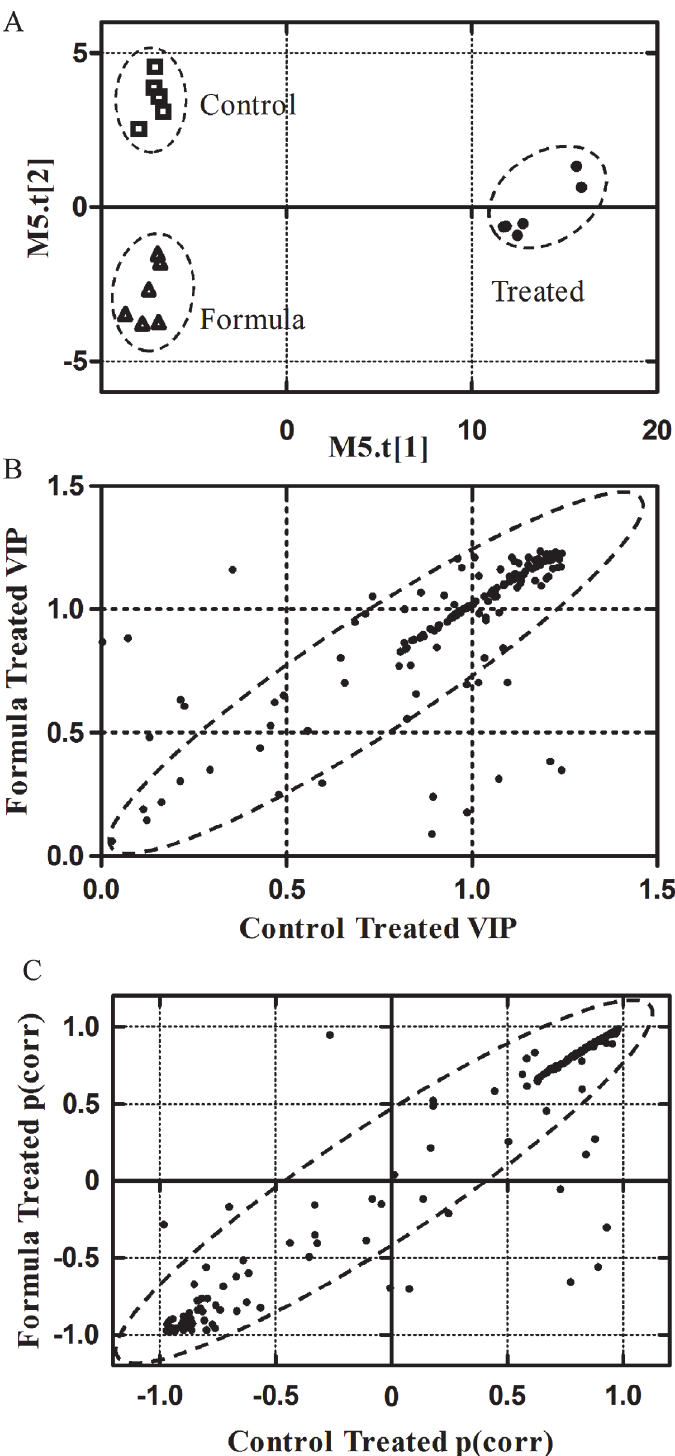
Fig 3. OPLS-DA (A) scores plot and SUS plots (B, C) for the multivariate statistical analysis. The OPLS-DA (orthogonal partial least square discriminant analysis) scores plot (A) shows clustering of the metabolite profiles for control, formula and treated samples, indicating good models with strong separation. SUS (Shared and Unique Structures) plots constructed for VIP (variable influence on projection) (B) and p (corr) values (C) show significant metabolites and metabolite correlation, respectively, with shared